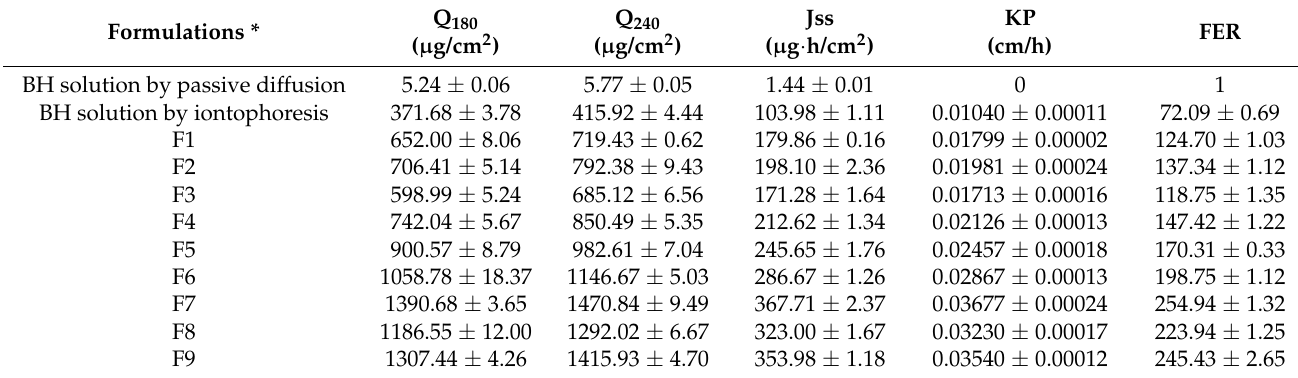
Table 4. Ex vivo permeation parameters of BH through rat skin.